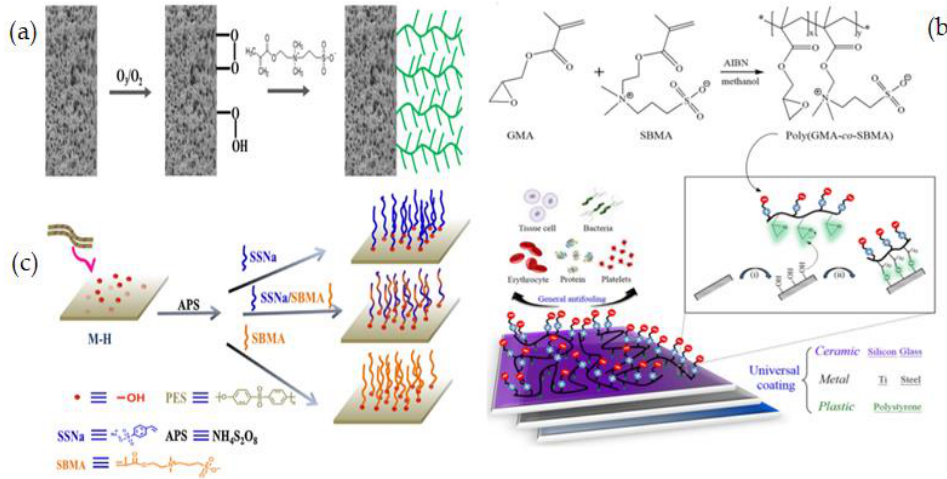
Figure 8. ( a ) Synthetic procedure of grafting ZW on PVDF membrane [137], ( b ) Synthesize and grafting to poly(GMA-co-SBMA) onto various surfaces via ultraviolet ozone pre-treatment and triethylamine (TEA) regulation of ring opening [140], ( c ) Schematic illustration of PES membrane functionalization [141].